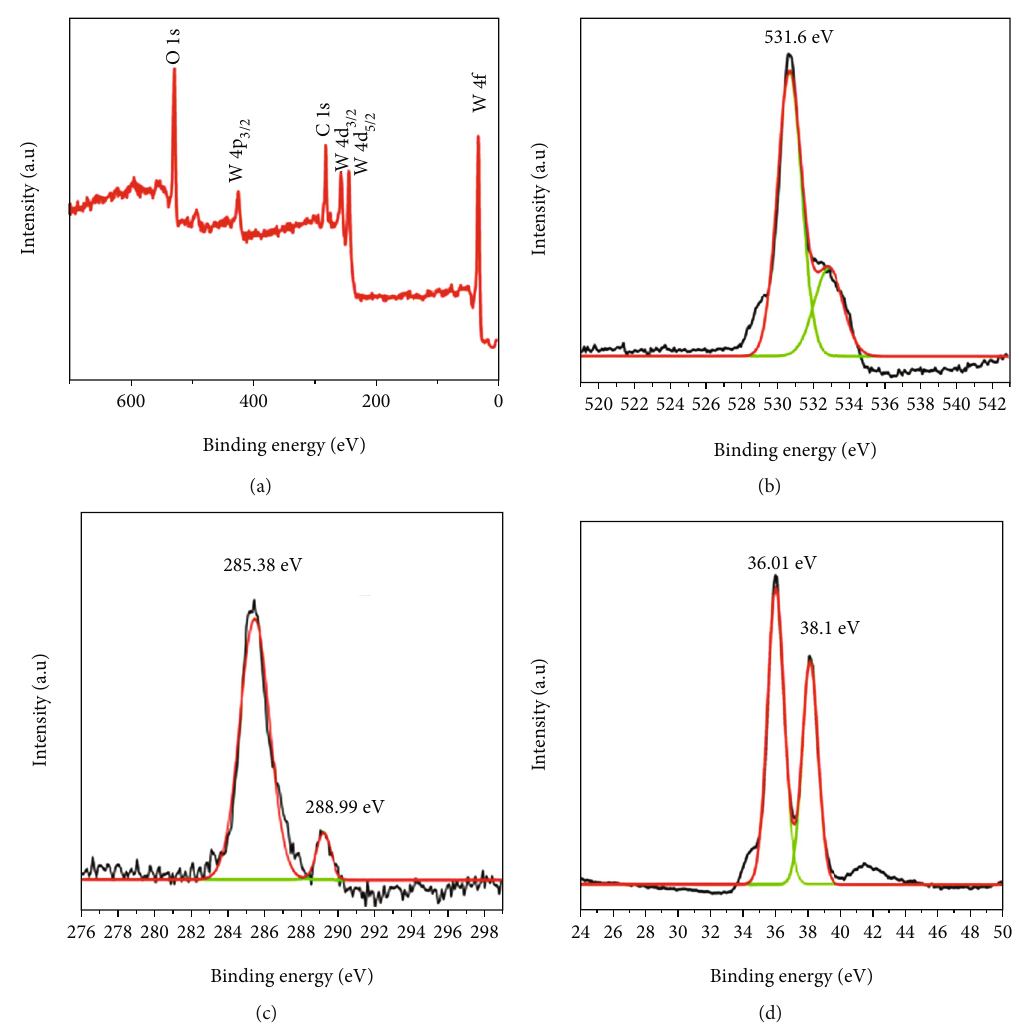
Figure 8: XPS image of prepared WO